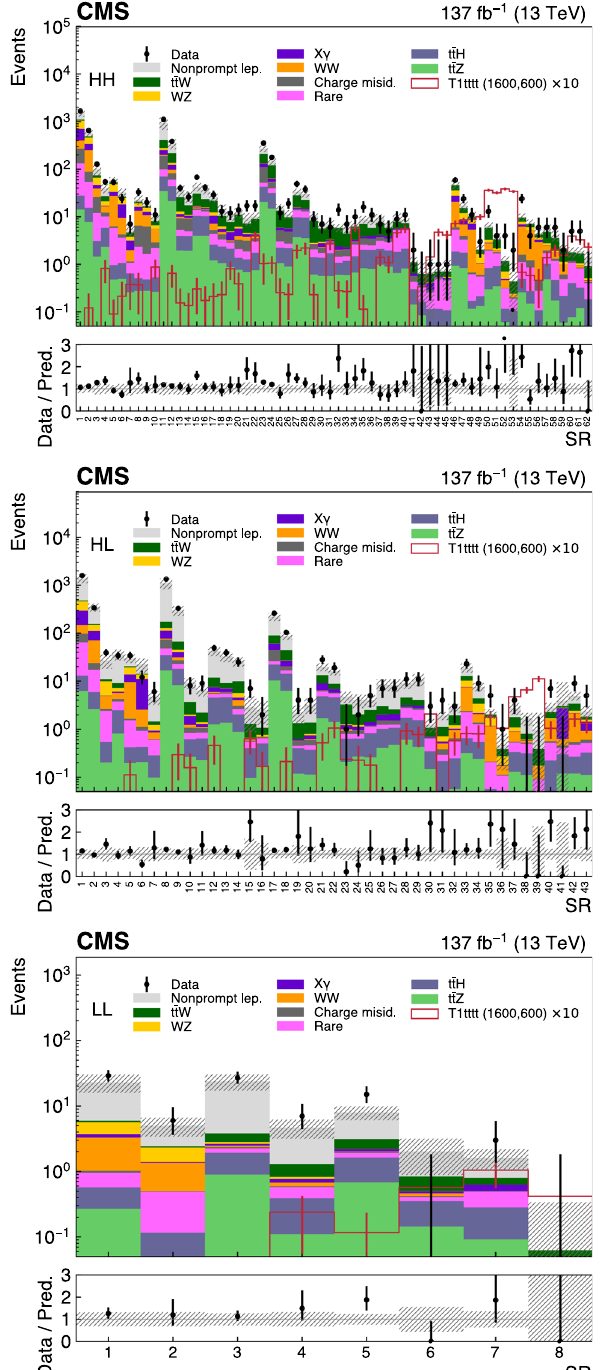
Fig. 6 Expected and observed SR yields for the LM, on-Z ML, off-Z ML signal categories. The hatched area represents the total statistical and systematic uncertainty in the background